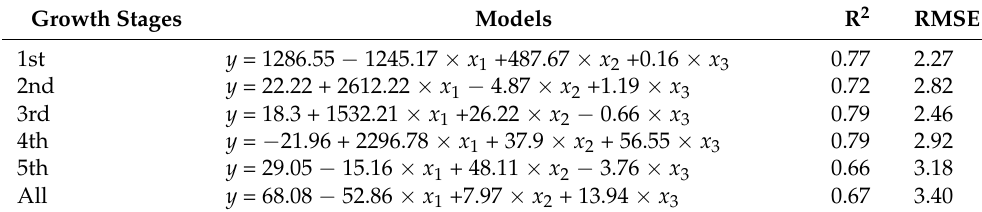
Table 6. Multiple variate linear regression analysis model in calibration datasets.